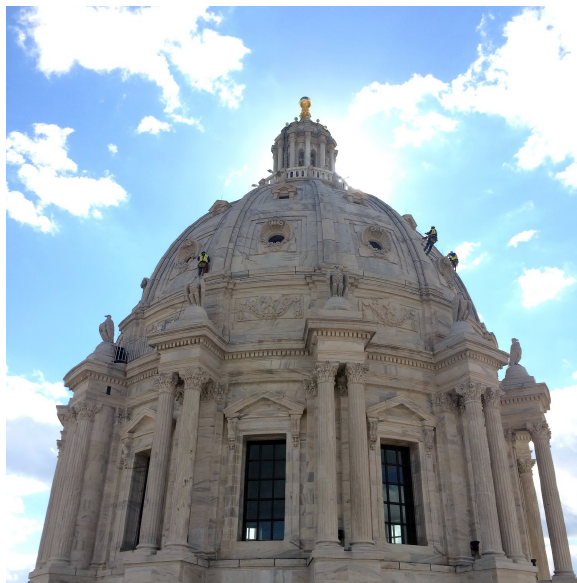
Figure 1: Marble condition assessments on the dome of the capitol were initially conducted by rappelling